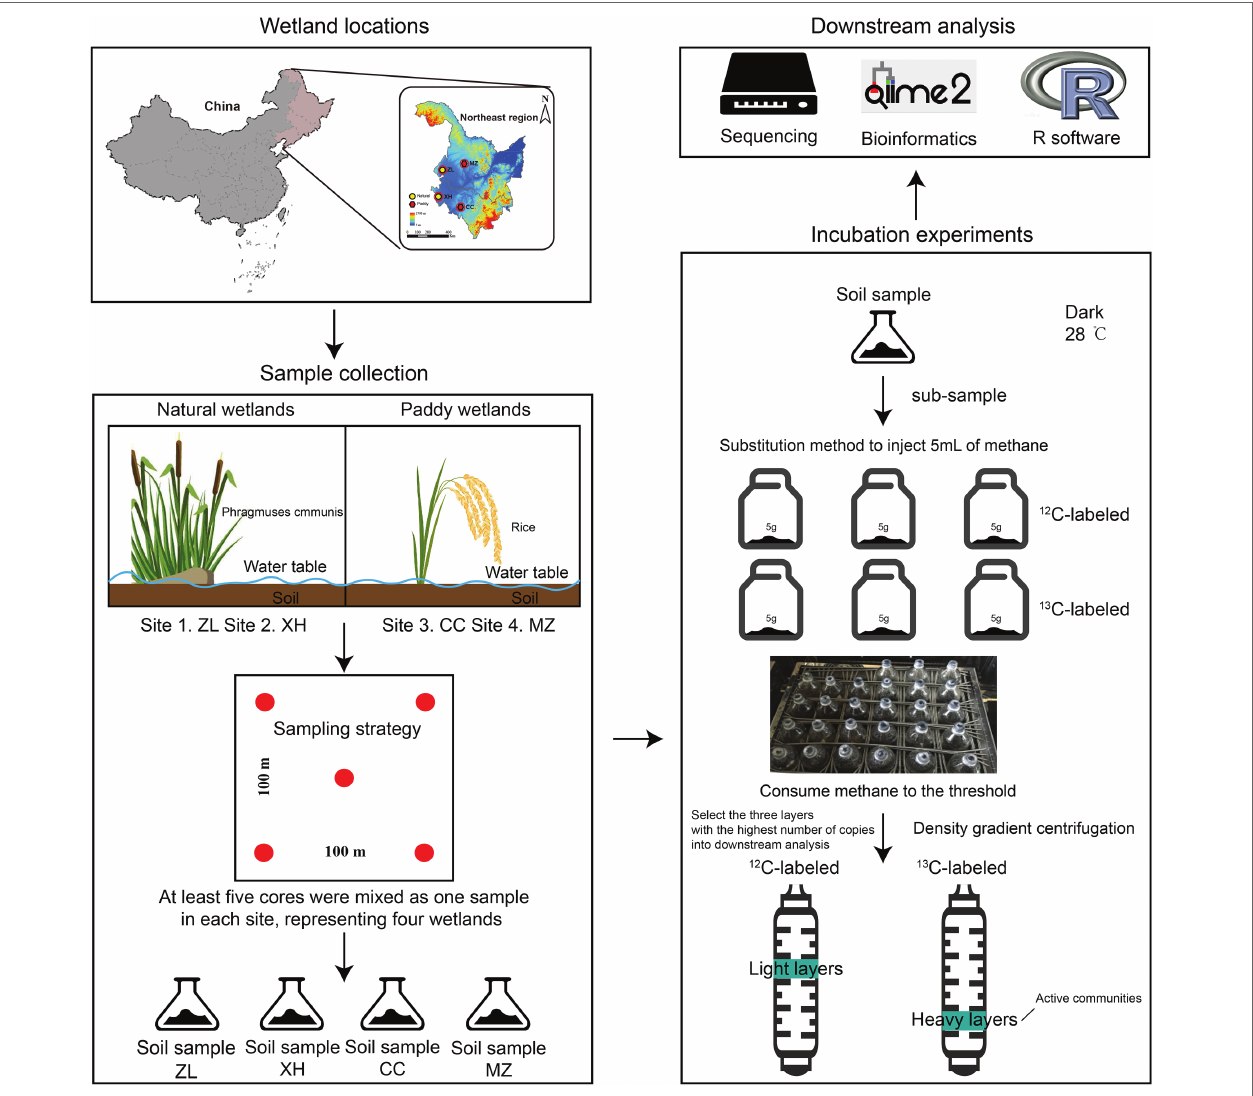
FIGURE 1 | A pipeline of the study on the differences in active methanotrophic communities between paddy and natural wetlands. CC on behalf of Changchun paddy wetland, MZ on behalf of Minzhu paddy wetland, XH on behalf of Xianghai natural wetland, and ZL on behalf of Zhalong natural